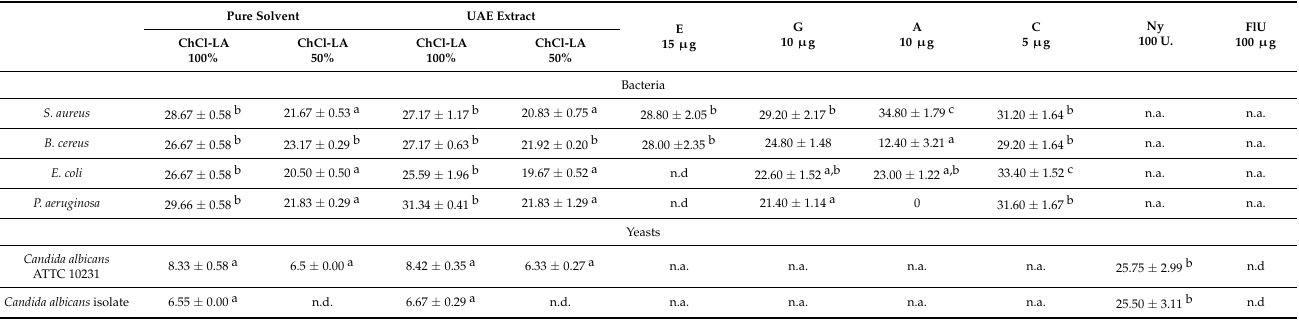
Table 5. Antibacterial and antifungal activity of pure ChCl-LA and ChCl-LA extract (two different concentrations) in comparison with the selected antibiotics. The results are expressed as the zone of inhibition (Mean value ± Standard Deviation) in